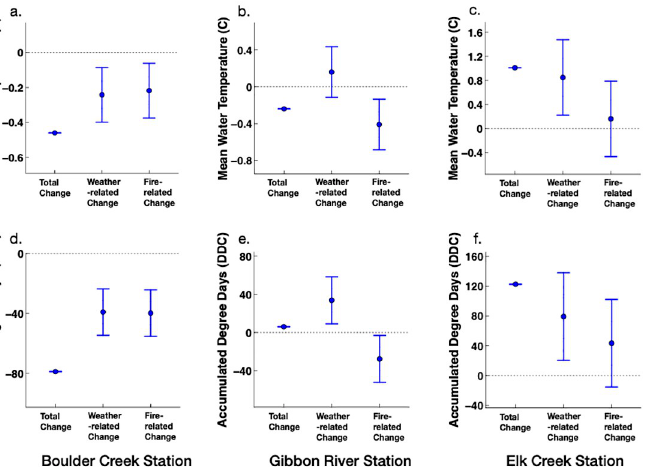
Fig 6. Weather and wildfire contributions on the post-fire change in the winter mean water temperature and accumulated degree days at (a, d) Boulder Creek, (b, e) Gibbon River, and (c, f) Elk Creek stream sites. Filled circles represent point estimates and the bars signify the 95% confidence intervals (1.96 x